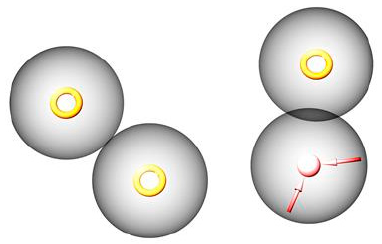
Figure 3. Pharmacophore model. Hydrogen acceptor—pink arrow. Aromatic groups—orange rings.